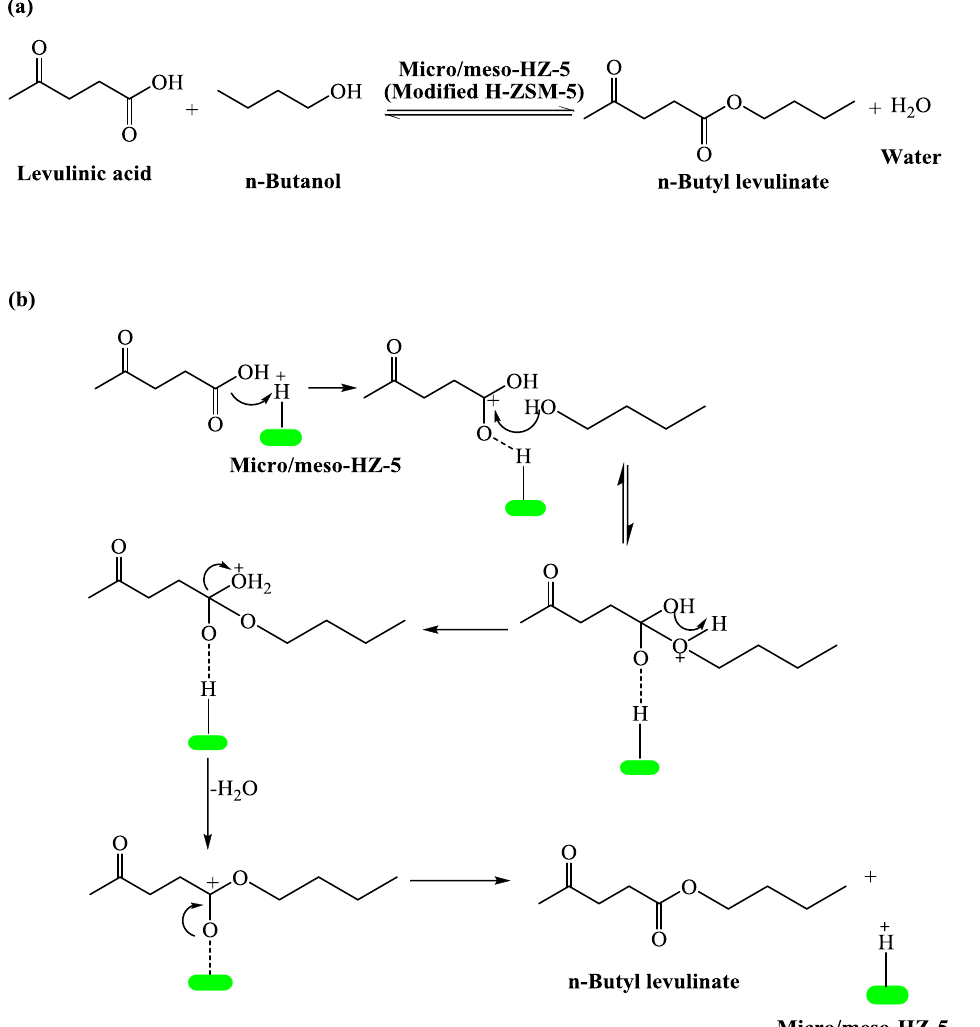
Figure 10. ( a ) Synthesis of n-butyl levulinate over micro/meso-HZ-5 and ( b ) proposed reaction mechanism for the esterification of levulinic acid with n -butanol over the micro/meso-HZ-5 catalyst [116] .